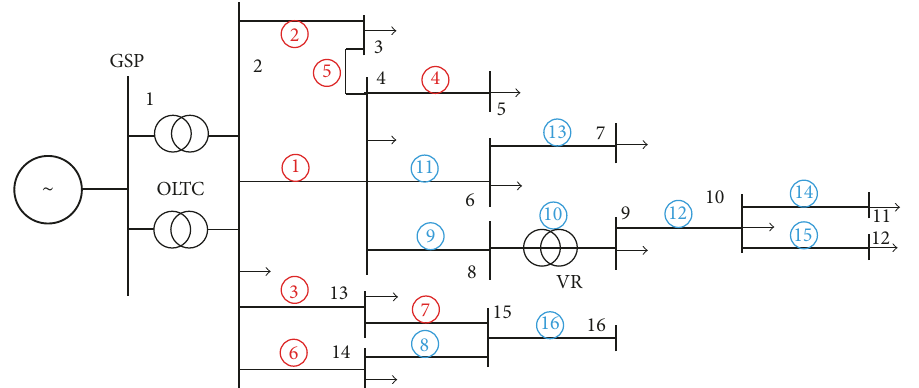
Figure 2: Ranking of branch in UKGDS 86.